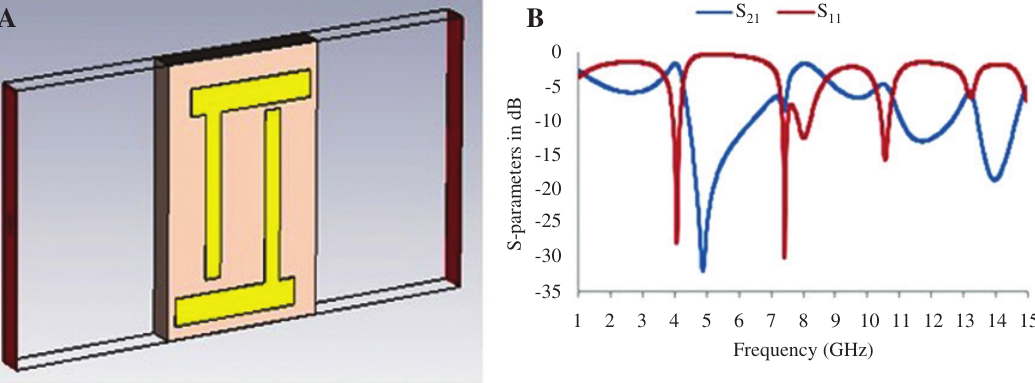
Figure 5: (A) Simulation geometry for x -axis wave propagation and (B) S-parameters (reflection and transmission coefficient) of the proposed unit cell structure for x -axis wave propagation.